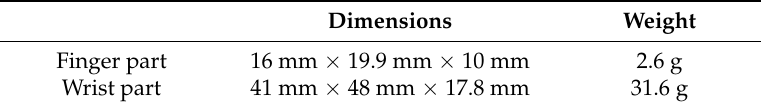
Figure 1. Wrist-watch-type wearable device for measuring tremors. Table 2. Dimensions and weight of the designed wearable device.